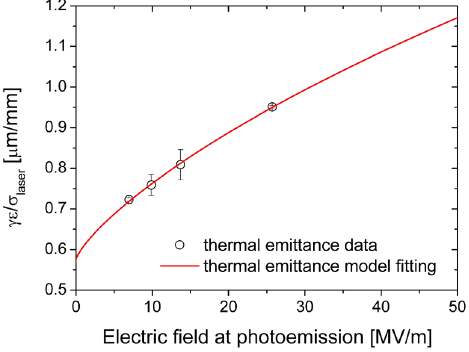
FIG. 4. QE before and after the vacuum accident.